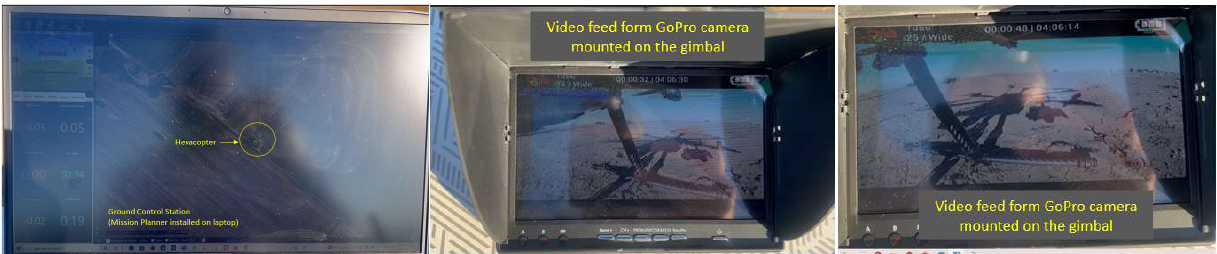
Figure 22. Mission planner interface. Images acquired by GoPro camera mounted on the hexacopter.